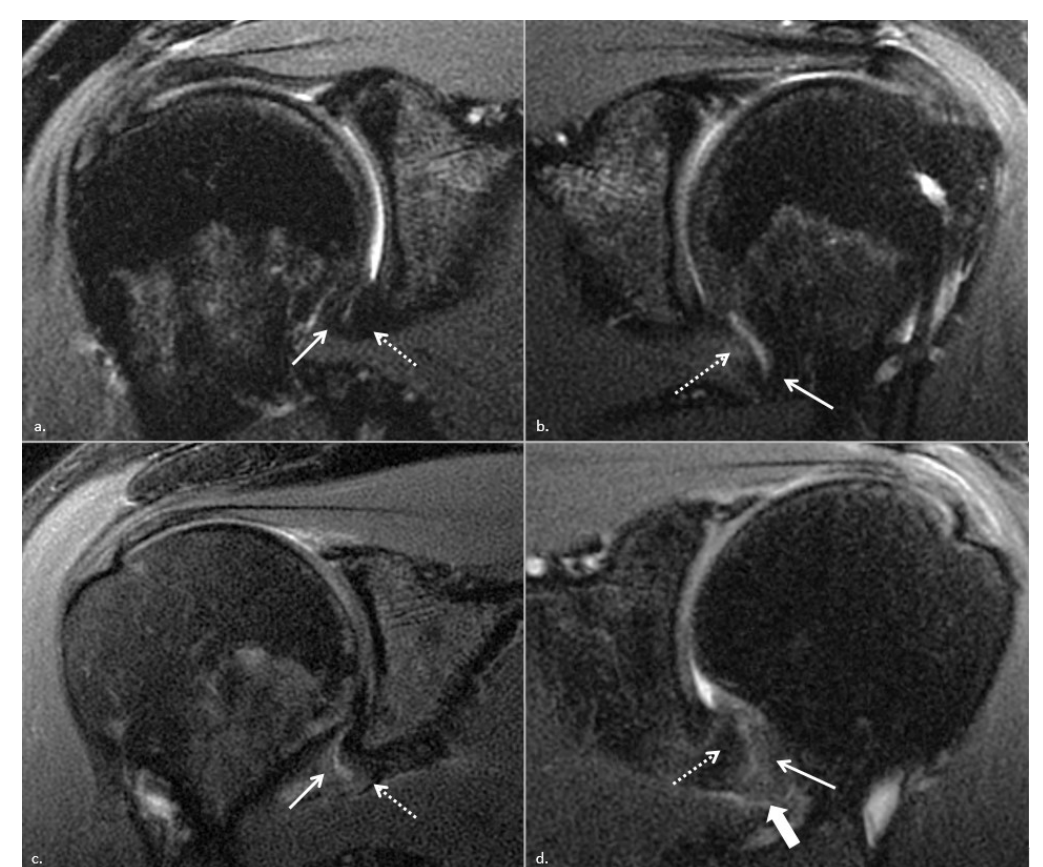
Figure 1. ( a – d ) Frontal oblique non-contrast fat-suppressed T2-weighted fast spin-echo MRI shows method used to grade glenohumeral inferior ligament signal on its glenoidal (white arrow) and humeral (dotted arrow) insertions, without signal abnormality in the right shoulder of a 55-year-old woman with adhesive capsulitis graded 1 in ( a ), a discontinuous glenoidal side IGHL hypersignal graded 2 in the left shoulder of the same woman with contralateral adhesive capsulitis in ( b ), a global both side IGHL hypersignal graded 3 in the left shoulder of a 43-year-old man with adhesive capsulitis in ( c ) and an overflow of the hypersignal in adjacent soft tissues (thick white arrow) graded 4 in the right shoulder of a 46 years old man with adhesive capsulitis in ( d ).